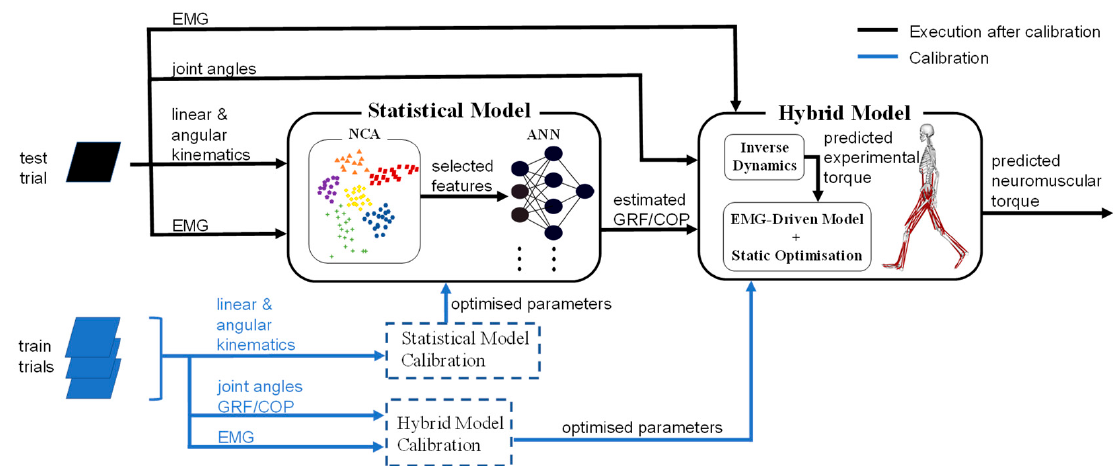
Figure 1. The schematic flowchart of the entire investigating paradigm for each subject. Prior to both GRF/COP estimation and torque computation, statistical and hybrid biomechanical models are calibrated using measured data from three train trials. After statistical model calibration, a set of optimal features as inputs to the ANN model are selected by NCA from the measured data of the test trial for the GRF/COP estimation. After the hybrid model calibration, GRF/COP estimates are fed into the biomechanical models (musculoskeletal and hybrid models) for joint torque prediction.